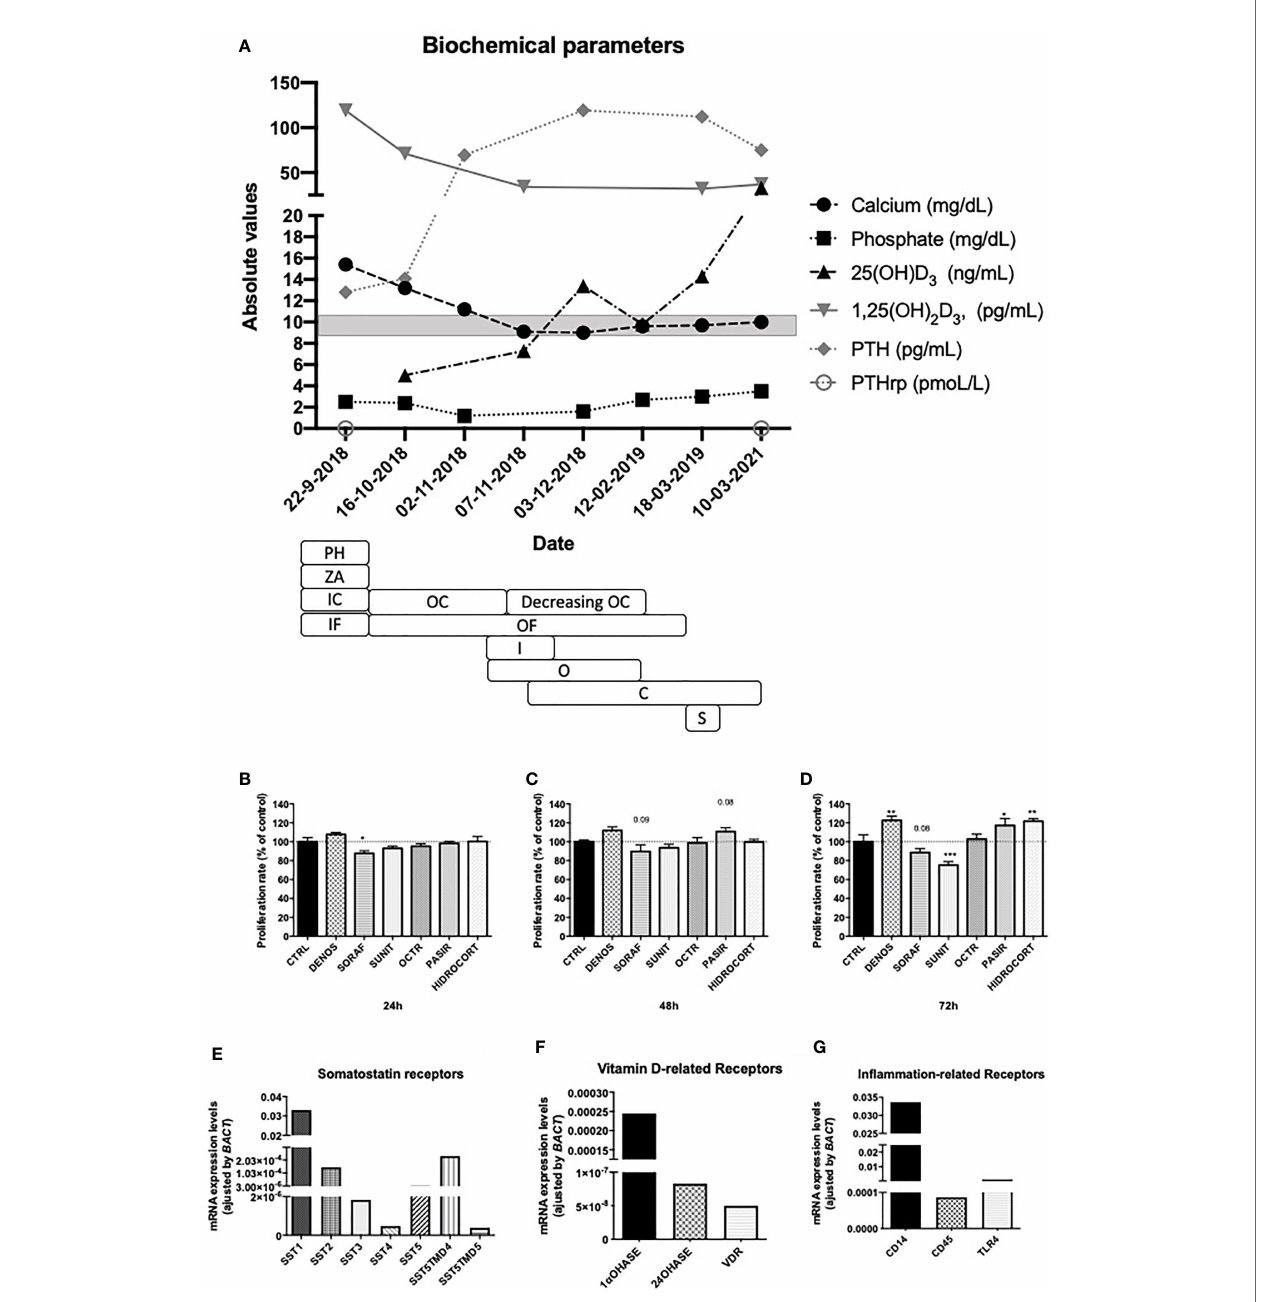
FIGURE 2 | (A) Time-line representation of evaluated biochemical parameters since diagnosis until two years after surgery. Serum values of calcium, phosphate, PTH, PTHrP, 25(OH)D 3, 1,25(OH) 2 D 3 are depicted. Medical treatment is also represented. PH, parenteral hydration; ZA, zolendronic acid; IC, intravenous corticoids; IV intravenous furosemide; OC; oral corticoids; OF, oral furosemide; I, imatinib; O, octreotide; C, calcifediol; S, surgery. The gray square represents normal calcium serum levels. Cell proliferation assay of primary cultures of the described GIST tumor after 24, 48 and 72 hours of incubation with denosumab, sorafenib, sunitinib, octreotide, pasireotide and hydrocortisone (B – D) . Molecular expression of somatostatin receptors (E) , vitamin D- related enzymes and receptors (F) and in fl ammation related genes (G) using qPCR. *p < 0.05; **p < 0.01; ***p <